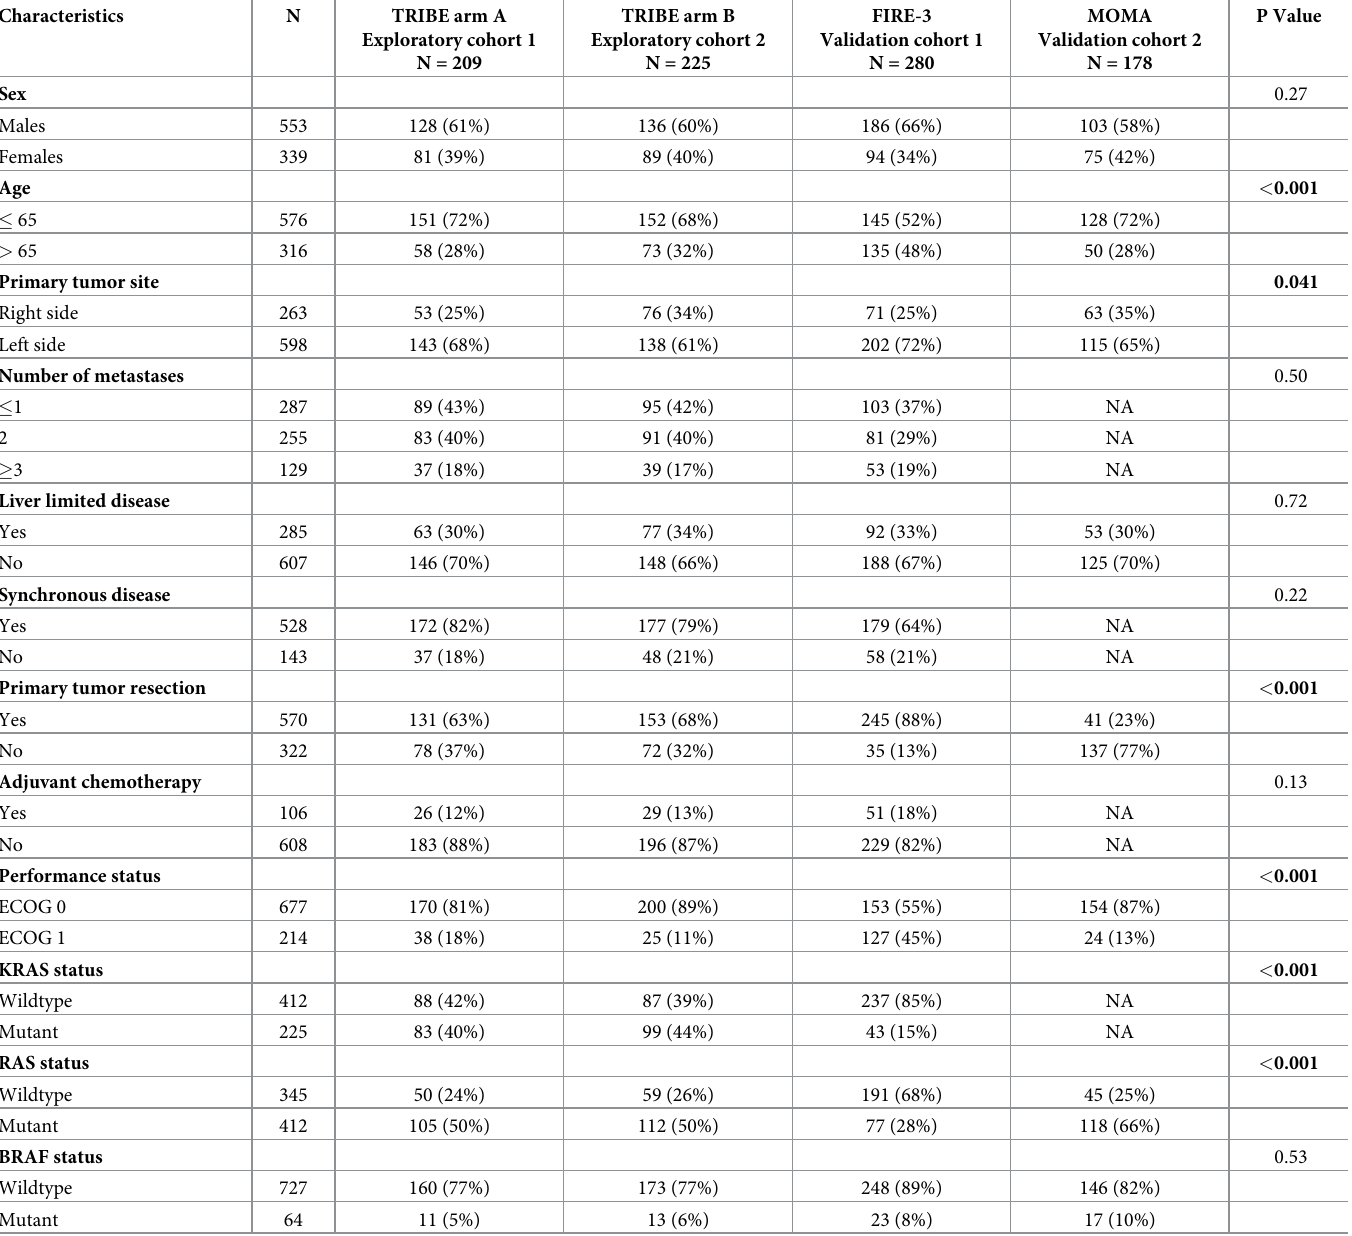
Table 2. Clinicopathological features of